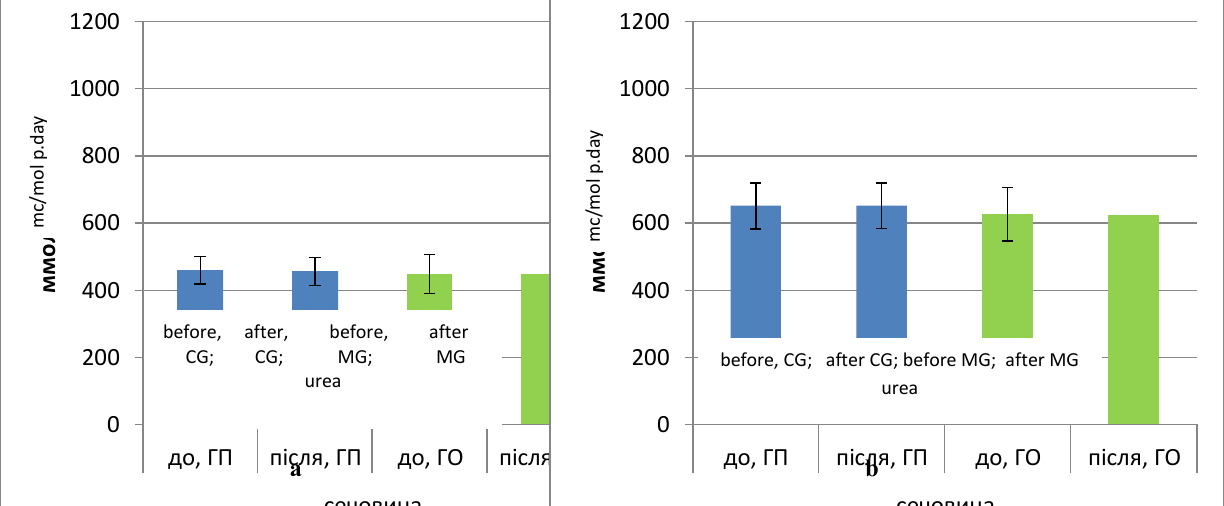
Fig.3. Indicators of bio-chemical monitoring by excretion of urea before and after experiment in a-lactate cluster (of main and comparative groups): a) by bicycle stress test «Vita maxima»; b) by results of control special tests. (р ≥ 0.05). CG – comparative group, MG – main group.